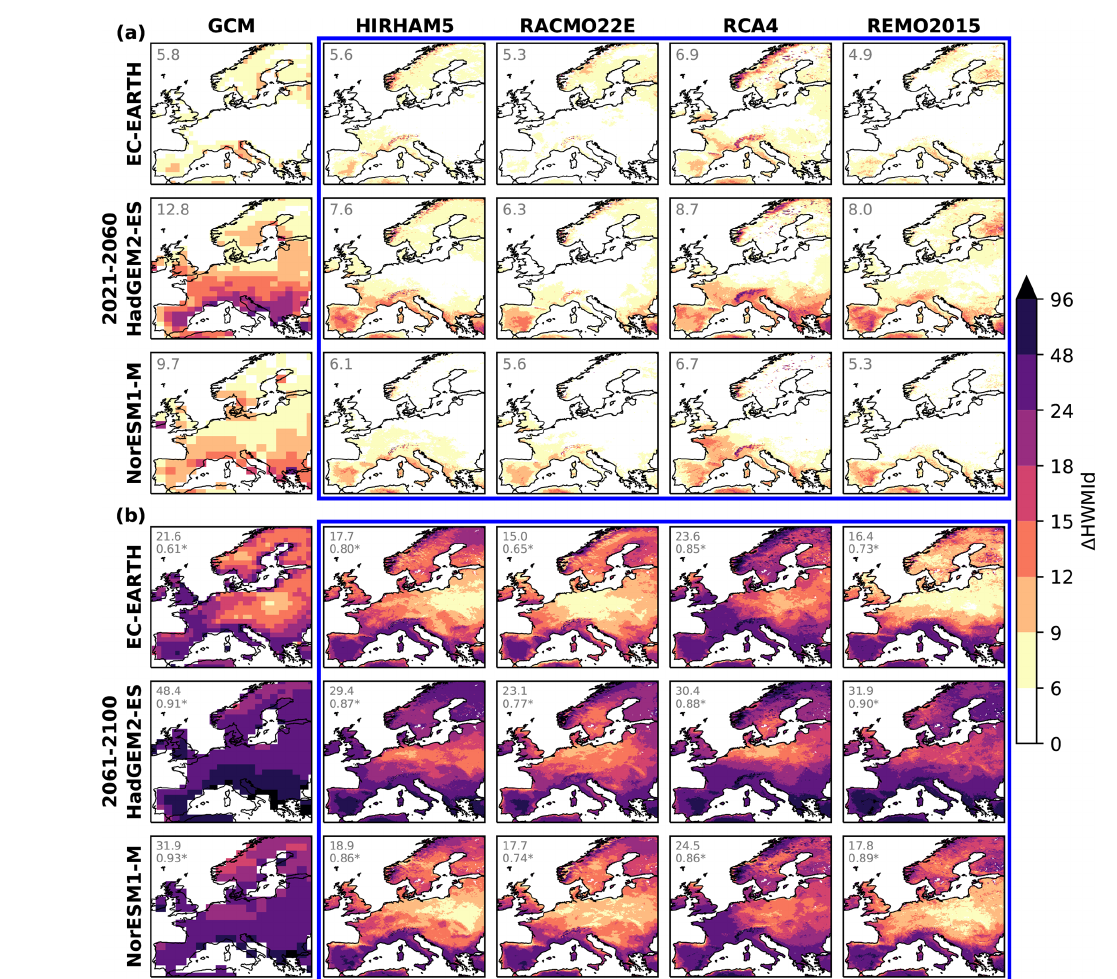
Figure 6. Change in climatological mean HWMId in the nearest decades ( a : 2021–2060) and in the end of the century ( b : 2061–2100) relative to the recent past climate (Fig. 3), with results from the RCM simulation matrix placed inside the blue rectangles. The first numeral in each map shows the area-weighted average, and the second (only presented in b ) is the spatial r between the two periods (with “ ∗ ” indicating statistical significance at p < 0 .